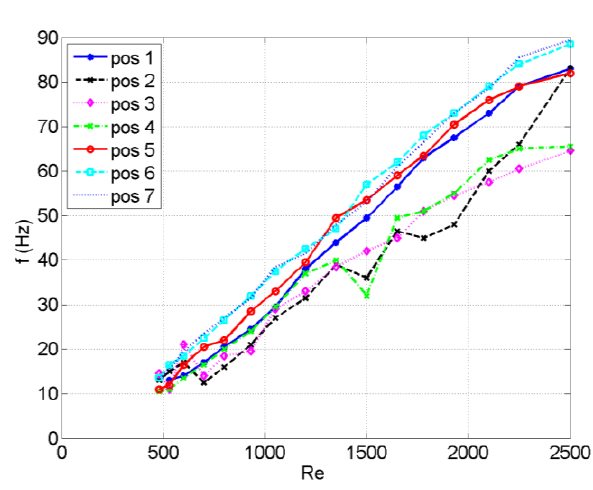
Figure 11. Relationship between the frequency and Reynolds numbers for D/d = 2.5